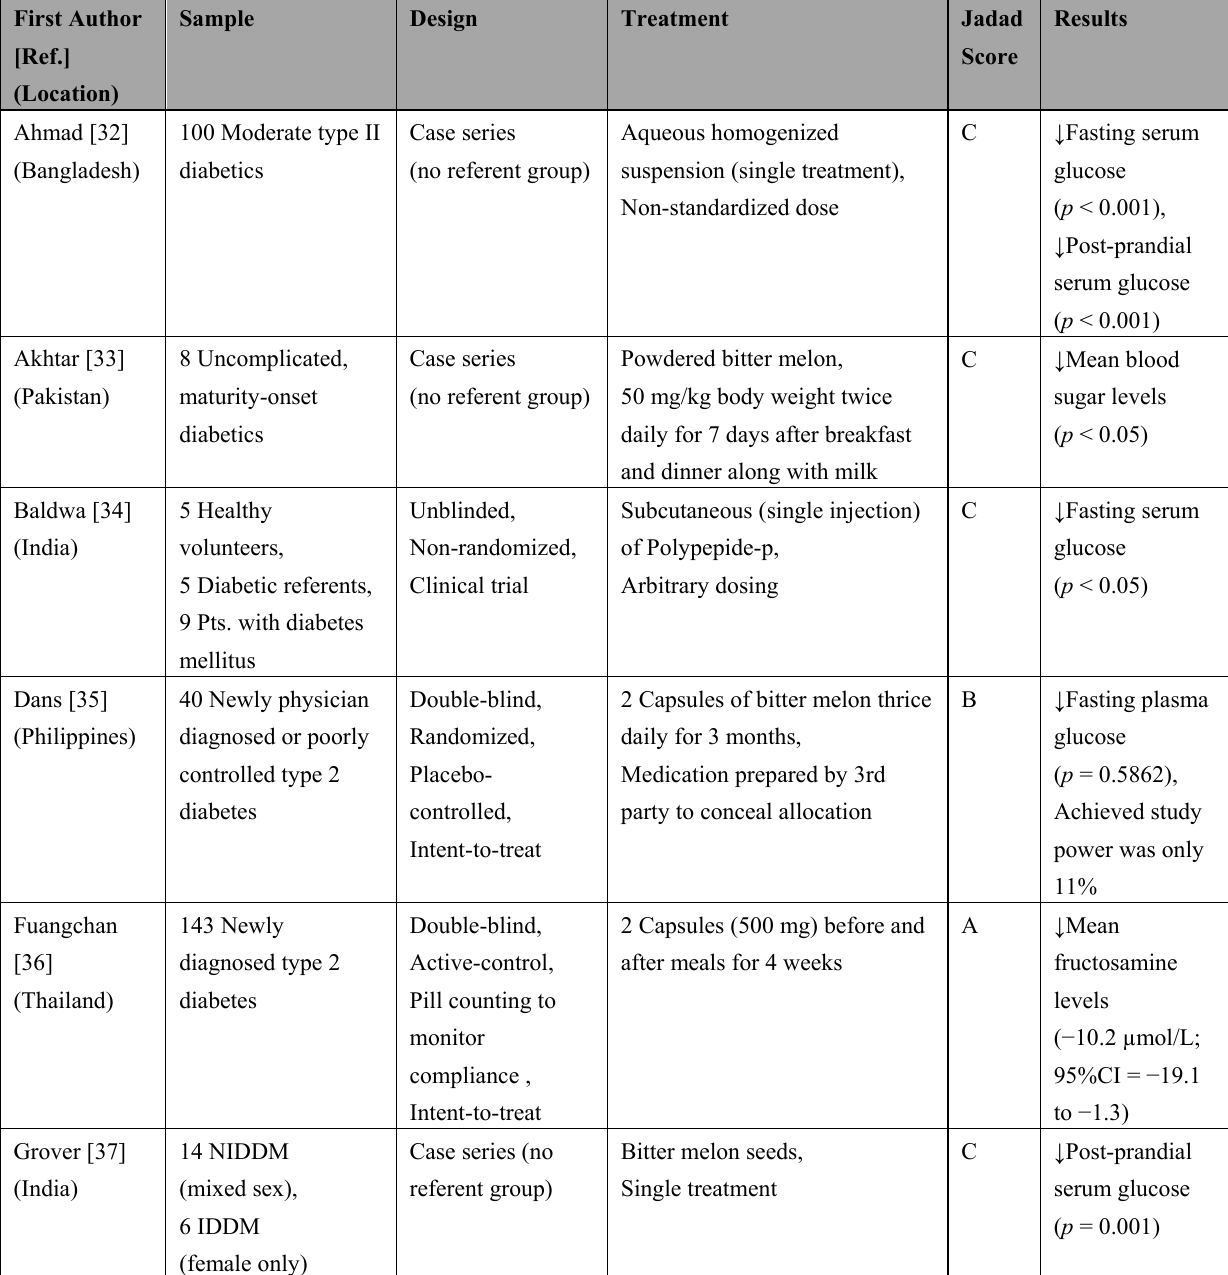
Table 2. Summary of clinical studies on bitter melon ( Momordica charantia ) §